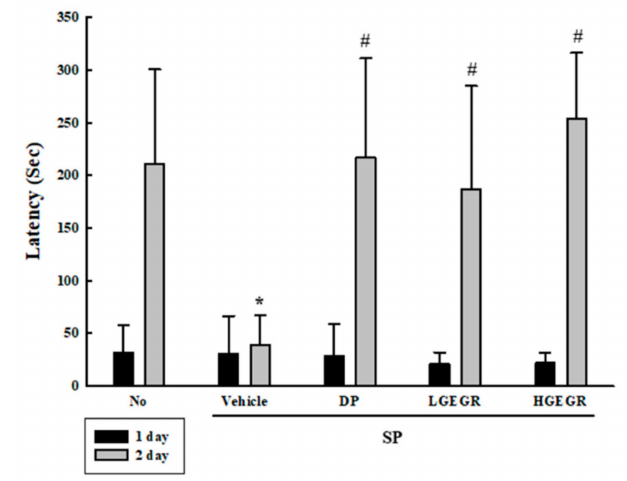
Figure 3. Alteration of cognition in SP + GEGR treated mice. A passive avoidance test was used to determine step-through latency for 300 s. Behavioral changes in mice were measured after SP injection. Ten to twelve mice per group underwent cognitive defect testing. Data represent the means ± SD of duplicates and analyzed by Kruskal-Wallis and Mann-Whitney U test. * p < 0.05 compared with the No treated group. # p < 0.05 compared with the SP + Vehicle treated group. Abbreviation: DP, donepezil; GEGR, gallotannin-enriched extract of Galla Rhois; SP,